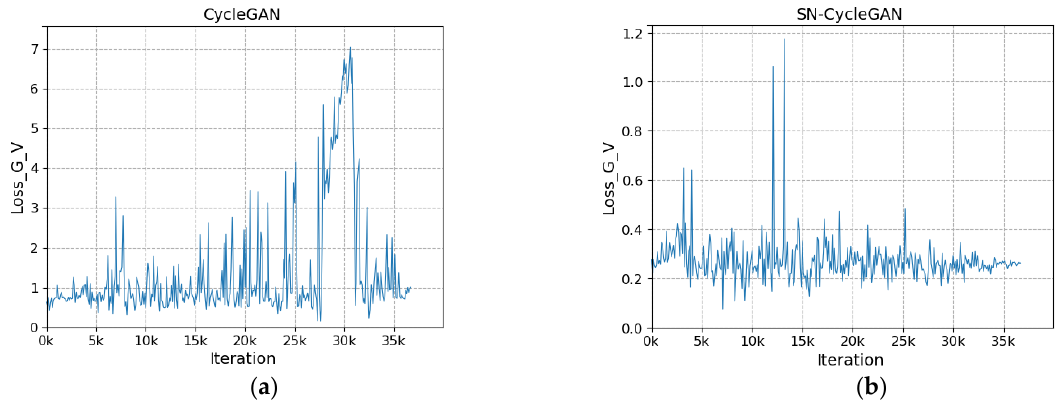
Figure 10. Comparison of generator loss for visible light. ( a ) CycleGAN, ( b ) SN-CycleGAN.